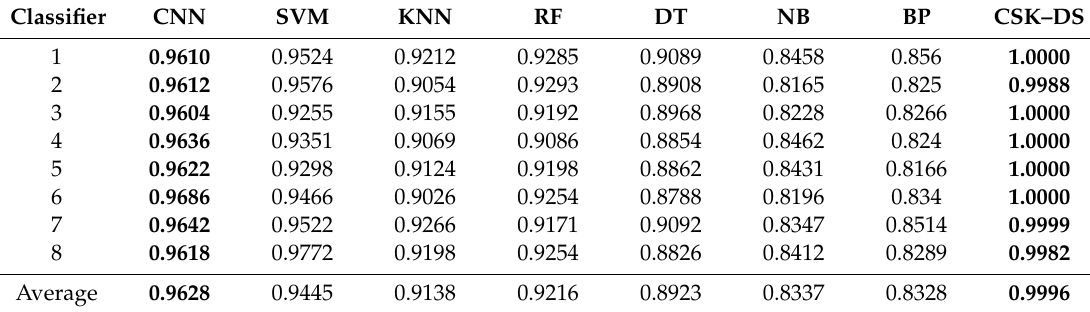
Table 3. Classification rates of test data with the threshold filter.